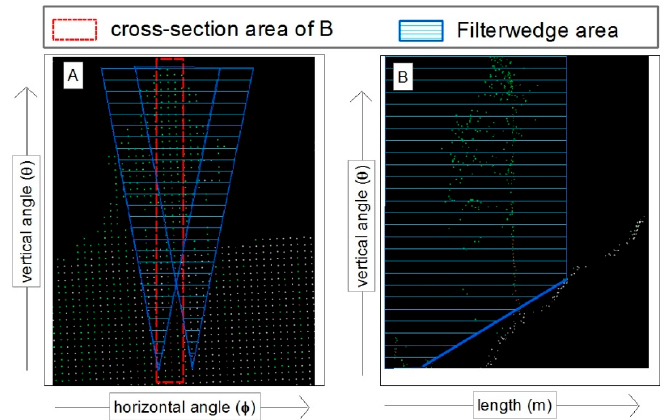
Figure 1. View to terrain from the centre of scanner ( A ); and cross-section of a terrain ( B